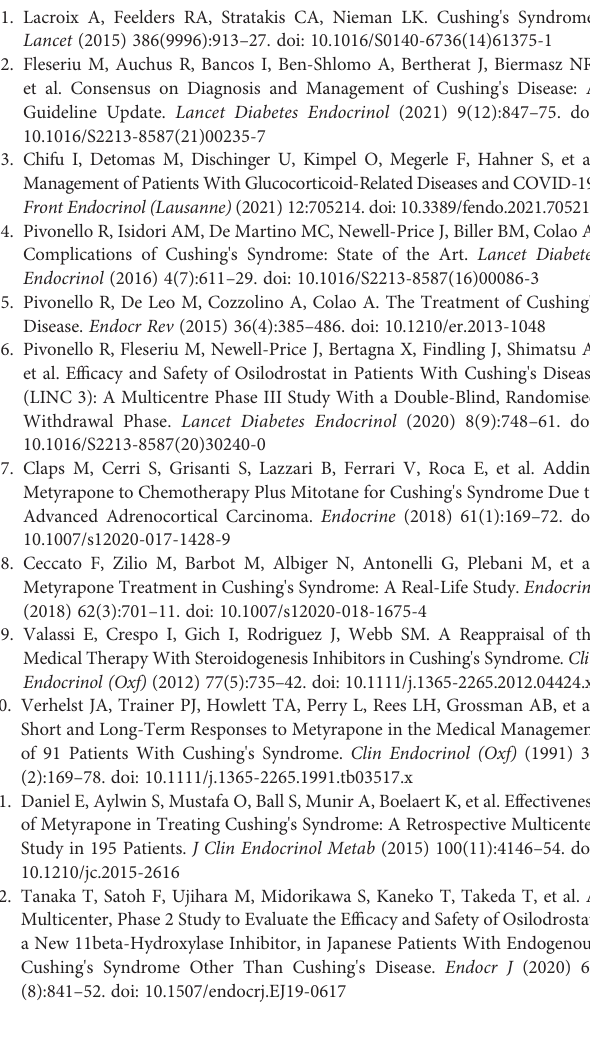
Supplementary Figure 1 | Delta percentage of transaminase and creatinine under metyrapone or osilodrostat treatment during follow-up compared with baseline. Changes in percentage fromT0 (baseline) oftransaminases andcreatinine throughout the study. Follow-up was performed at 2 weeks (T1), 4 weeks (T2) and 12 weeks (T3). ALT, alanine transaminase; AST, aspartate aminotransferase; GGT,